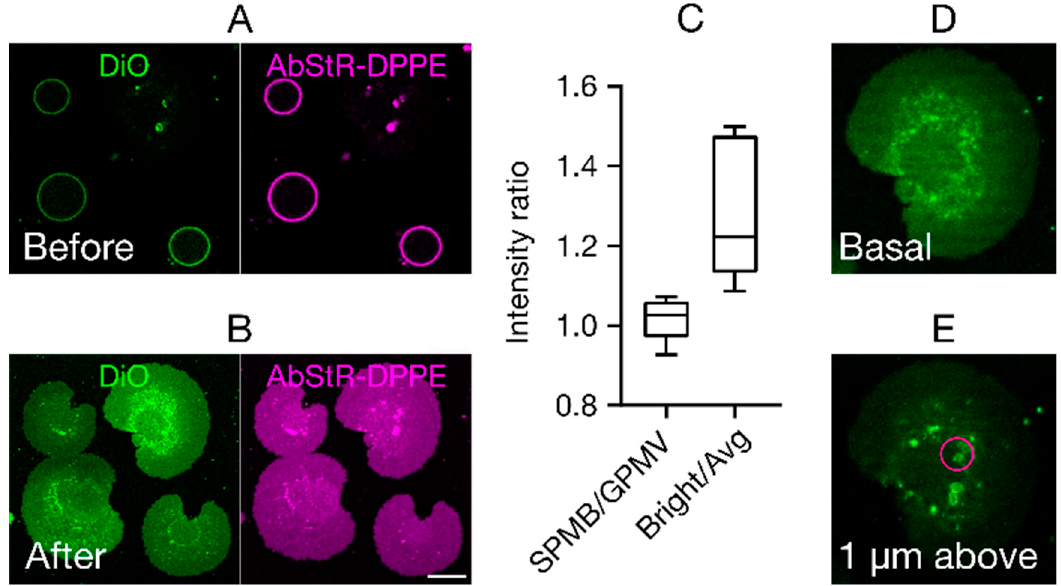
Figure 2. Supported plasma membrane bilayers (SPMBs). ( A , B ) Representative confocal microscopy images of the equatorial plane ( A ) of the GPMVs before and ( B ) of the SPMBs on the cover glass after applying the acoustic pressure field. Membrane labelling was done by the membrane dye DiO (green) and the fluorescently labelled fluorescent lipid analog Abberior-Star Red (AbStR; magenta) DPPE. Scale bar is 10 µ m. ( C ) Fluorescence intensity ratios. Intensities in SPMBs divided by those in GPMVs (SPMB / GPMV) and in bright spots in SPMBs divided by average intensity outside those spots (Bright / Avg); “1” indicates equal intensities. ( D , E ) Representative confocal images of SPMBs ( D ) at the basal plane and ( E ) 1 µ m above the basal plane, showing bright tubular structures above the membrane plane, causing the appearance of bright spots.